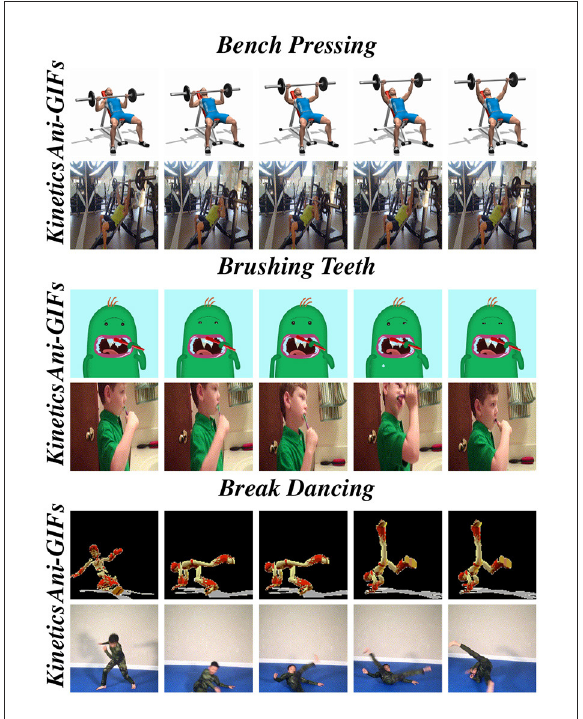
FIGURE1 This figure highlights the spatiotemporal domain gap between Ani-GIFs , our proposed benchmark dataset, and GIFs of the real domain—from the Kinetics dataset (Kay et al., 2017)—for three classes: Bench Pressing , Brushing Teeth , and Break Dancing . This illustrates the domain gap between real vs. animated